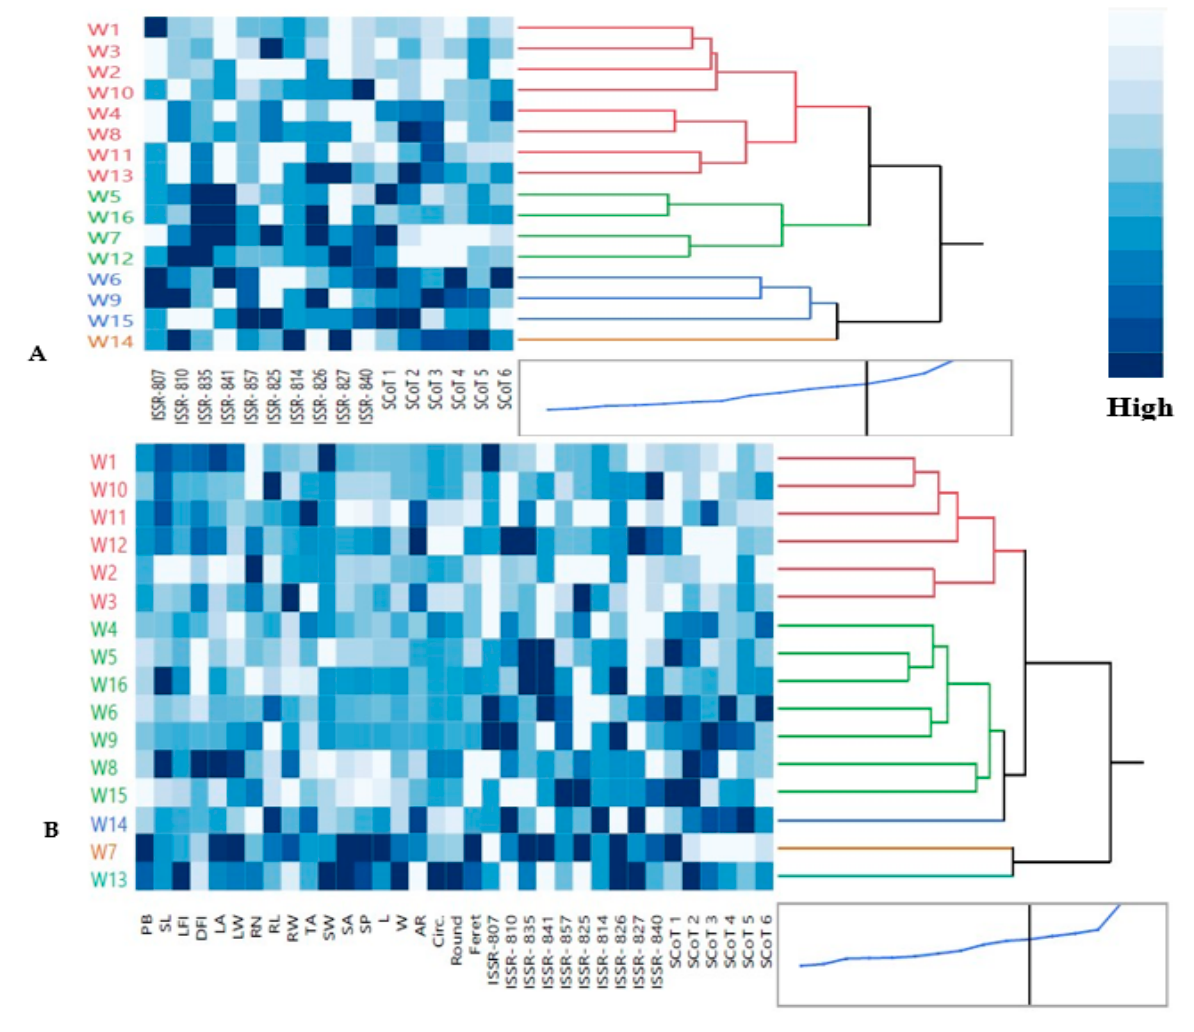
Figure 4. Hierarchical co-clustering dendrogram and heatmap using Ward’s method illustrating the distribution of 16 Egyptian T. aestivum cultivars based on: ( A ) the polymorphism values of combined molecular markers (10 ISSR and 6 SCoT); ( B ) 19 morphological and 16 molecular markers. Correlation levels are colored dark blue for high intensities and white for low intensities. Row clusters were obtained at genotype level, whereas the column cluster were recorded at trait or marker level.